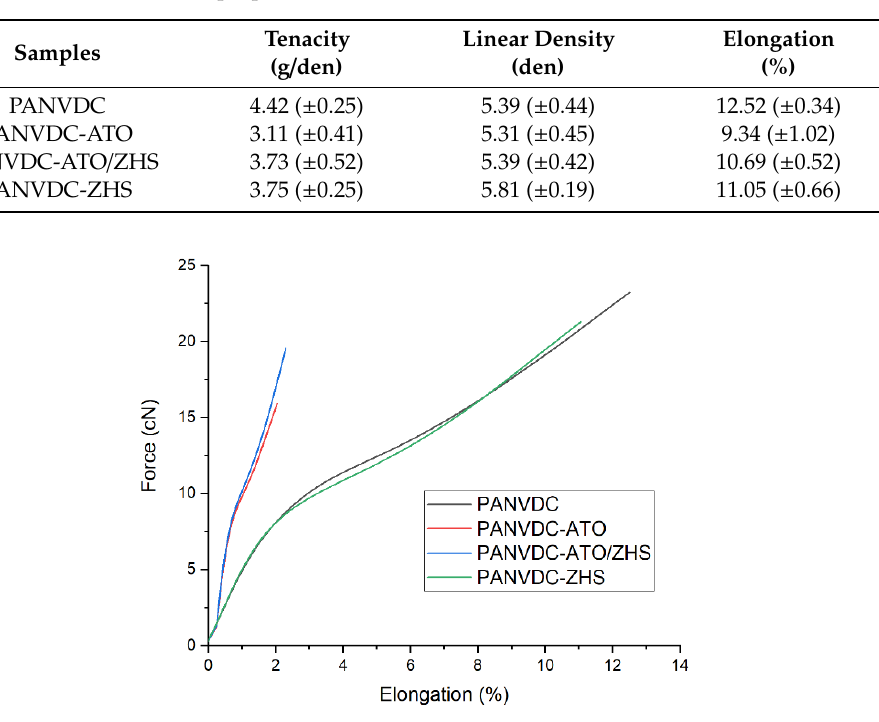
Figure 11. Average force/elongation-diagram of the drawn PANVDC fibers with the flame retardants. Table 8. Mechanical properties of the PANVDC fibers with the flame retardants.